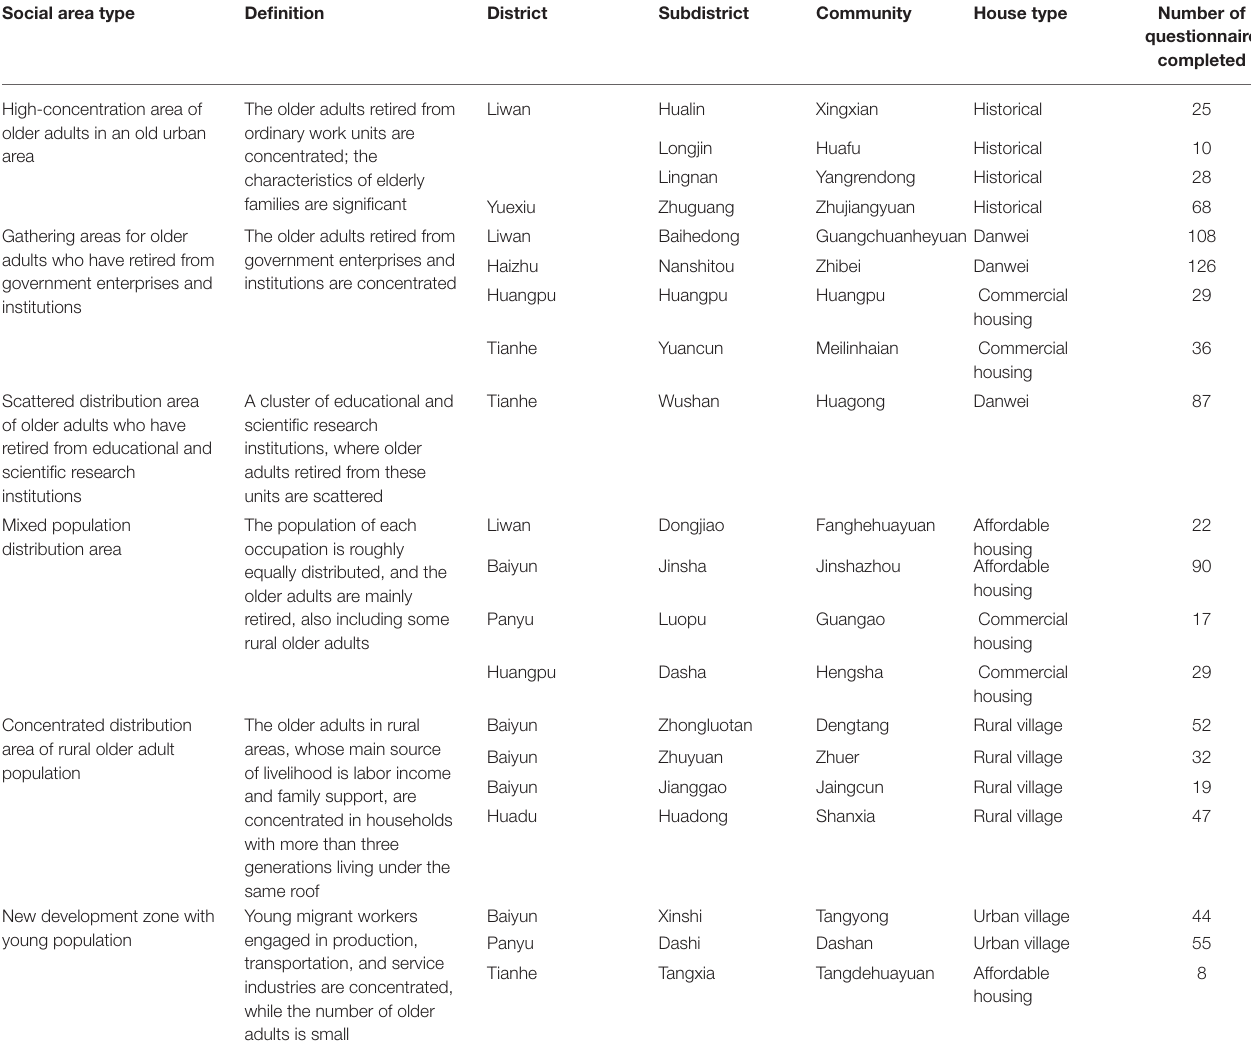
TABLE 1 | Surveyed communities.